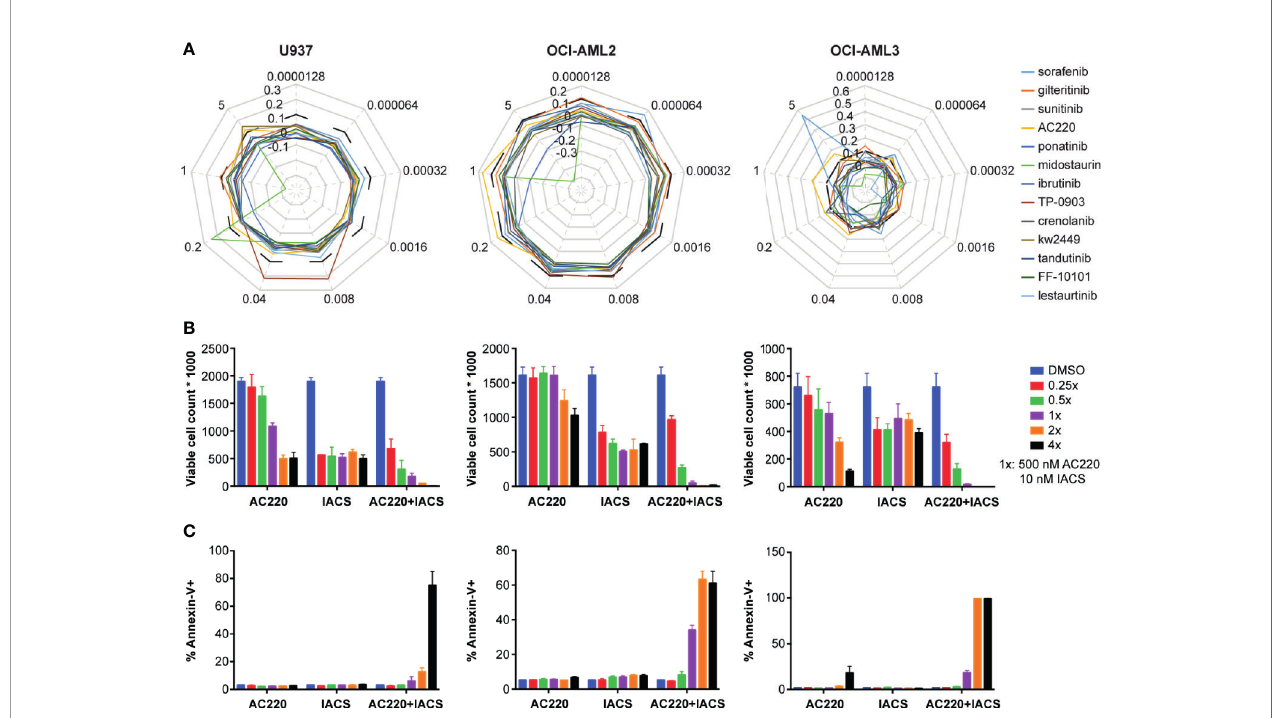
FIGURE 4 | The synergy between IACS-0101759 and AC220 was validated using ATP bioluminescence assay combined with the Bliss independence model, viable cell counting, and apoptosis assay at serial doses. (A) Bliss index (based on Bliss independence model) for 13 FLT3 inhibitors administered in 3 leukemia cell lines (U937, OCI-AML2 and OCI-AML3) at 9 different doses (0.0000128:5x:5 µM) in combination with 10 nM IACS-010759. Bliss index values higher than 0.1 (outside of the black dashed line) represents strong synergism. (B) Number of viable cells and (C) fraction of apoptotic cells following treatment at multiple doses (0.25x, 0.5x, 1x, 2x, and 4x) of AC220 (1x: 500 nM) and/or IACS-010759 (1x: 10 nM). Error bars show standard deviations. IACS: